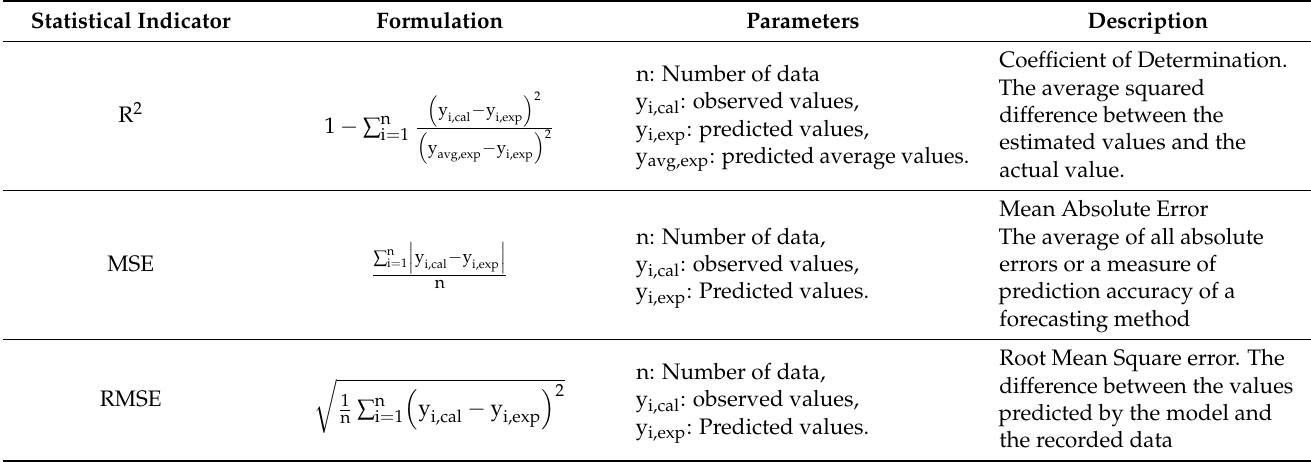
Table 2. Formula, Parameters, and Description of Descriptive Statistical indicators.